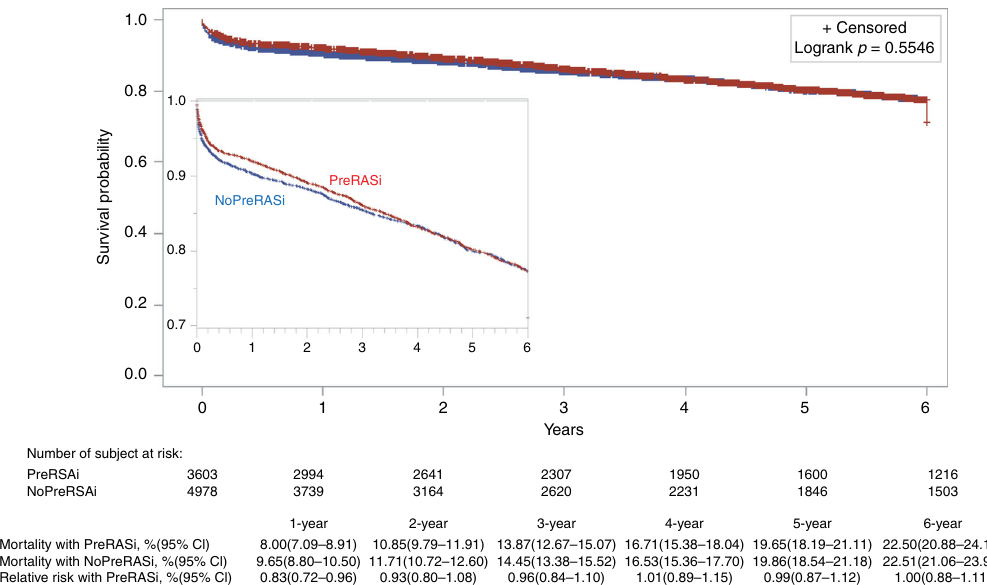
Mortality with PreRASi, %(95% Cl) Mortality with NoPreRASi, %(95% Cl) Relative risk with PreRASi, %(95% Cl) Fig. 3 Rates of survival in patients. Cumulative mortality with and without preoperative RASi (PreRASi) and the relative risk (95% con fi dence intervals in brackets) of PreRASi as compared with no-PreRASi are shown . Logrank p -value is analyzed with using the Kaplan – Meier method (unadjusted). The inset shows the same data on an enlarged y axis